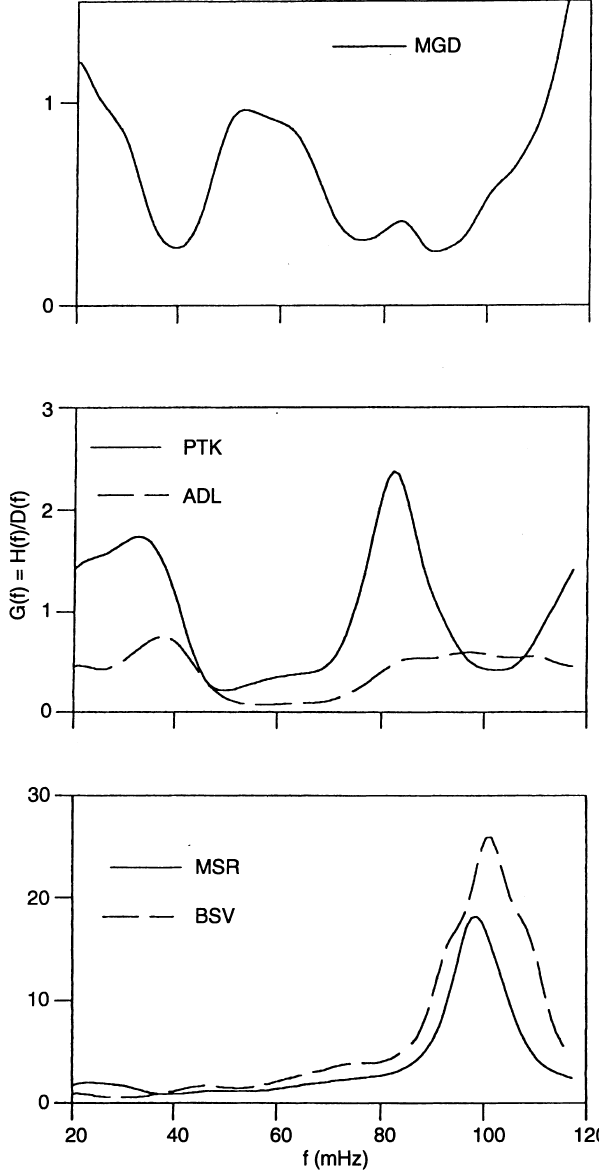
Fig. 9. The H (cid:133) f (cid:134) = D (cid:133) f (cid:134) spectral density ratio for